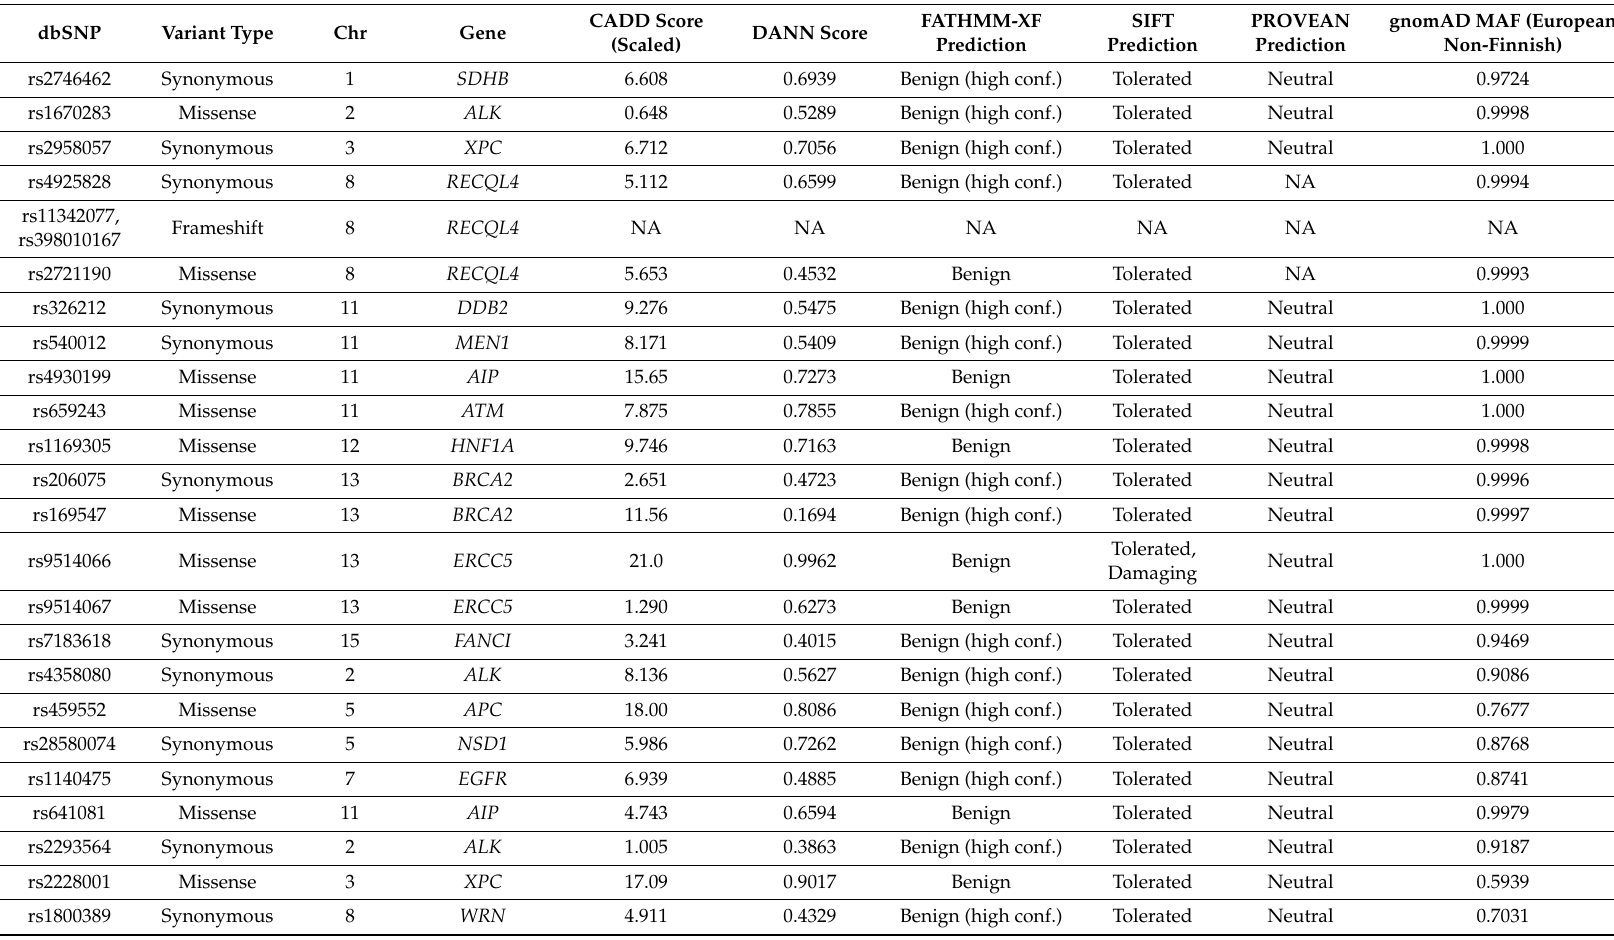
Table 3. In silico estimation of the variant’s pathogenicity. NA: not